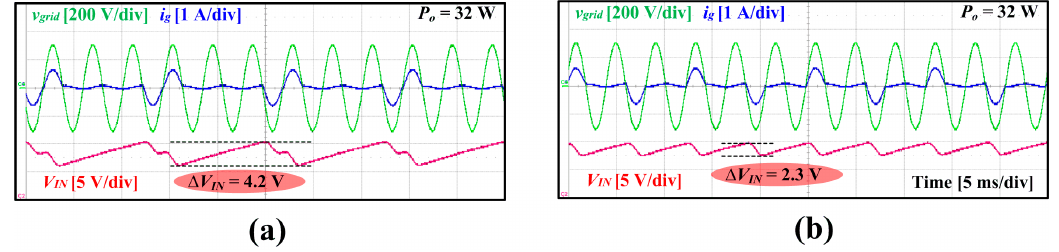
Figure 15. Input ripple voltage in ( a ) the conventional and ( b ) the advanced burst controls.